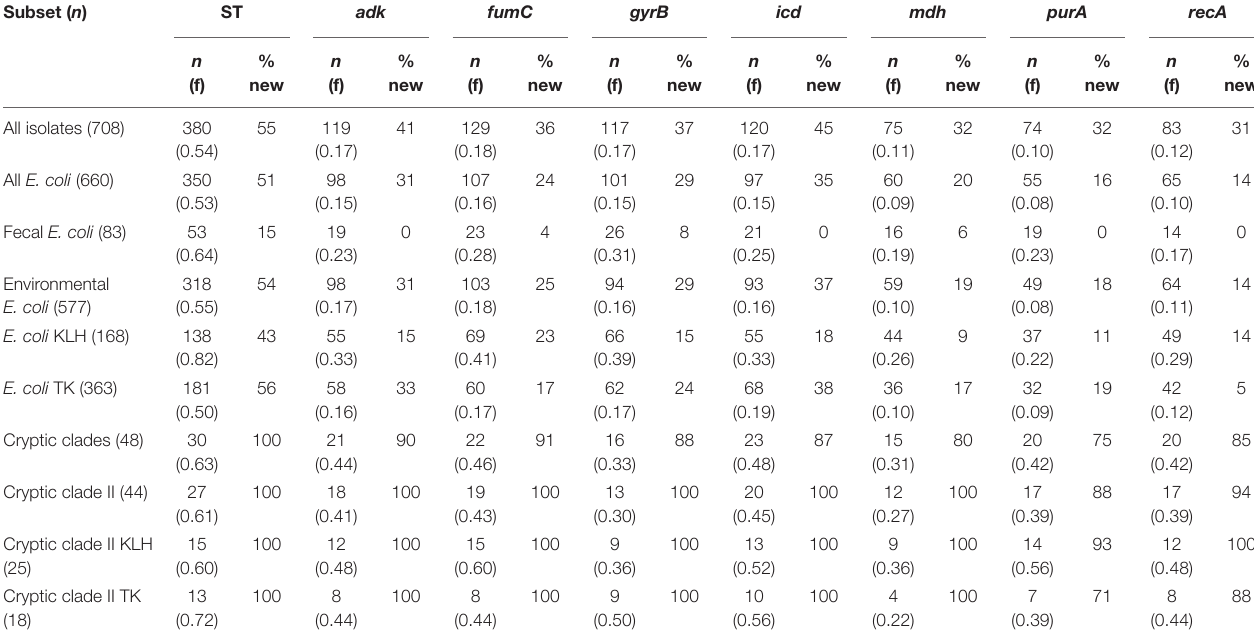
TABLE 3 | ST and allelic variation of data